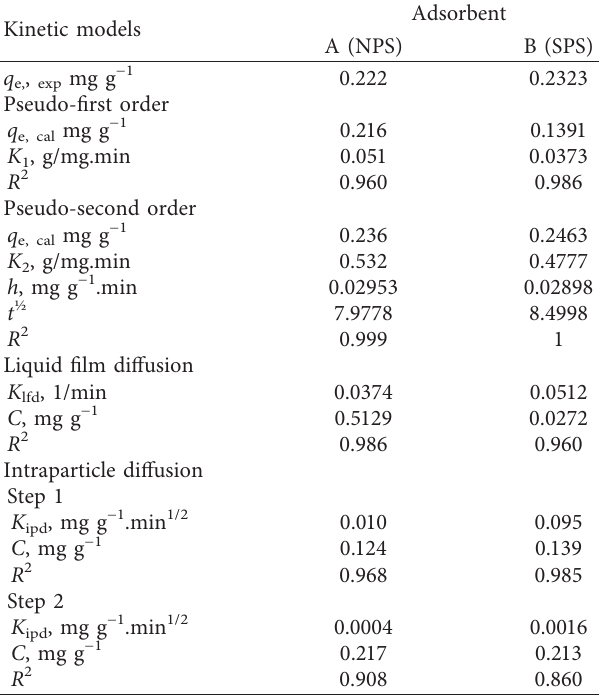
Figure 10: Plot of adsorption kinetic model (PFO, PSO, LFD, and IPD) for the FD removal by NPS and SPS (1 g adsorbent dosage; 10mg/L concentration of FD; 50ml solution volume; 3 h contact time; and 25 ° C temperature). Table 3: Parameters of adsorption kinetic model (PFO, PSO, LFD, and IPD) for the FD adsorption by NPS and SPS.